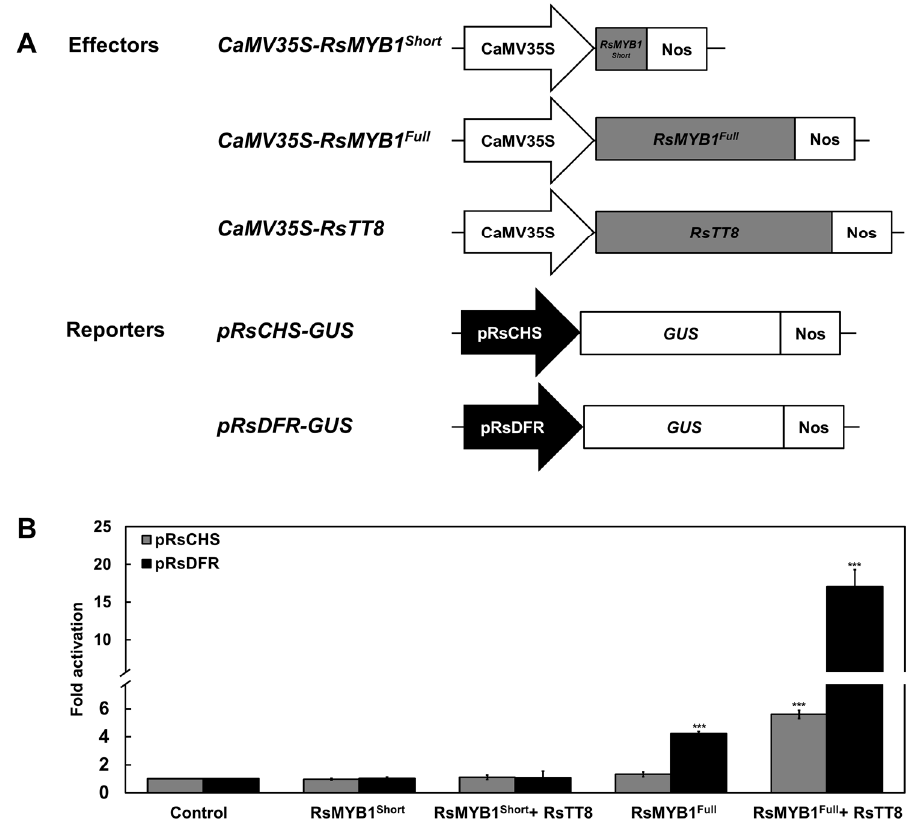
Figure 9. Transcriptional activation assay of the RsCHS and RsDFR promoters by RsMYB1 Full , RsMYB1 Short , and RsTT8. ( A ) Schematic diagrams of effector and reporter constructs used in the transcriptional activation assay. The effector construct harbors the coding sequences of RsMYB1 Full , RsMYB1 Short , and RsTT8 , respectively, driven by the 35S promoter and NOS terminator. The reporter constructs carry the RsCHS and RsDFR promoters driving GUS expression. ( B ) Regulatory consequences of the transient expression of RsMYB1 Short , RsMYB1 Full , and RsTT8 on RsCHS and RsDFR promoter activity. Results are mean values ± SD from three independent biological replicates. *** p < 0.001, as determined by Student’s paired t -test relative to the control.